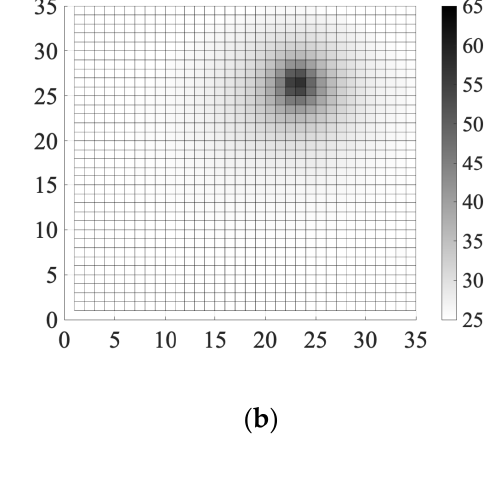
( d ) Figure 6. The temperature gradient of the surface of the solid dye. The irradiated pumping laser pulse was adjusted to ( a ) 2.5 ms, ( b ) 5 ms, and ( c ) 10 ms for 900 s. ( d ) The variation in the highest temperature of the irradiated surface of the solid dye. 4. Conclusions When the polymerized solid dye was irradiated with a laser, the fluorescence inten- sity rapidly became worse due to photodissociation. It was difficult to measure in real time and remotely with a conventional spectrometer. In this paper, we demonstrated real- time remote sensing with a static modulated Fourier transform spectrometer based on the modified Sagnac interferometer for the purpose of chasing the rapidly changing spectral information. The relationships between the optical path difference, the spectral resolution, the number of sampling data, and the measured wavenumber band were taken into ac- count to prevent aliasing. The data sampling frequency was inversely proportional to the optical path difference. Since a long optical path difference is required to obtain high res- olution, there is a problem in that the data sampling frequency decreases. Therefore, the spectral resolution was adjusted so that the data sampling frequency was twice the maxi- mum wavenumber in the measured wavenumber band. The solid dye was fabricated in the laboratory, and the fluorescence decreased due to photodissociation and was immediately observed when an interferogram measurement was Fourier transformed into a fluorescence spectrum. It was also observed that the real- time changes in temperature contribute to the fluorescence decrease in the solid dye. When the pumping laser was irradiated to the solid dye, the fluorescence decrease was observed for up to 900 s. In turn, the greatest decrease in fluorescence was 65%, and the shift in the fluorescence peak wavelength was observed from 590 to 580 nm. The re- sults of this study proved that real-time remote observations are possible using a static modulation Fourier transform spectroscopy. For this study, it is expected to be applied in